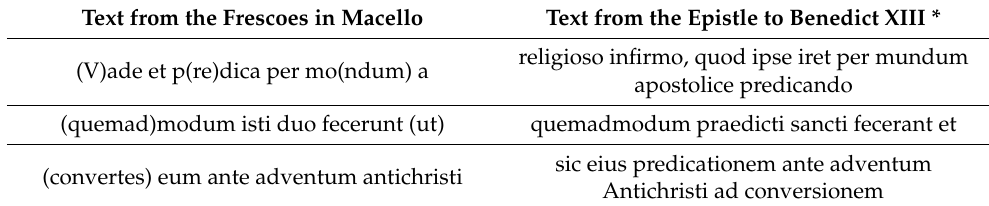
Table 1. Textual comparison, banderole 1 in the vision of beatus Vincentius. Text from the Frescoes in Macello Text from the Epistle to Benedict XIII *